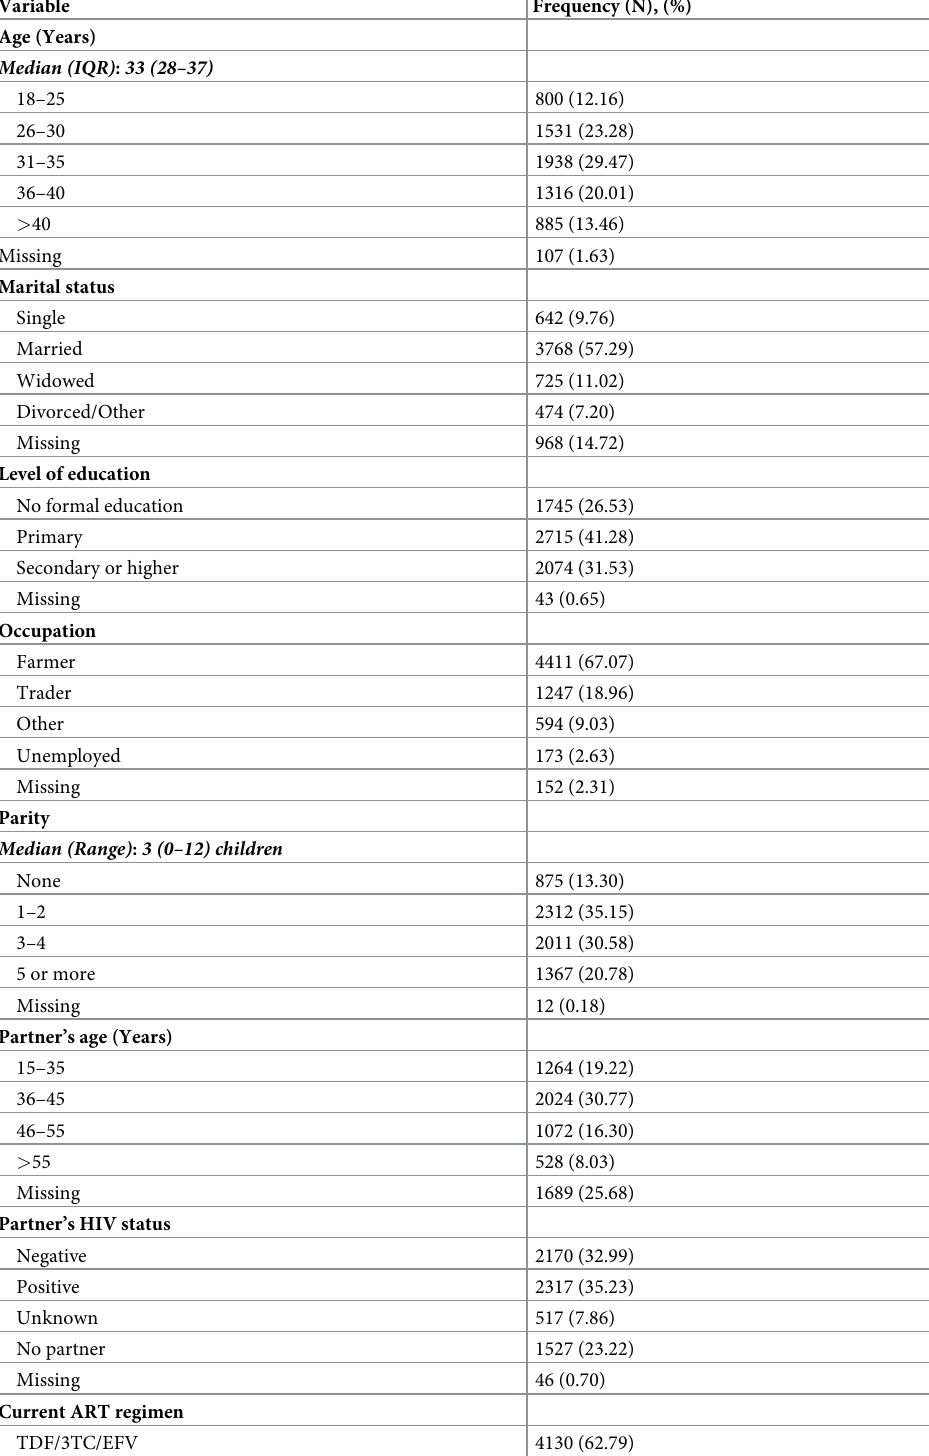
Table 1. Sociodemographic and clinical characteristics of female Hep B testers who participated in a patient-held smartcard scale-up study in Benue State, Nigeria (N =